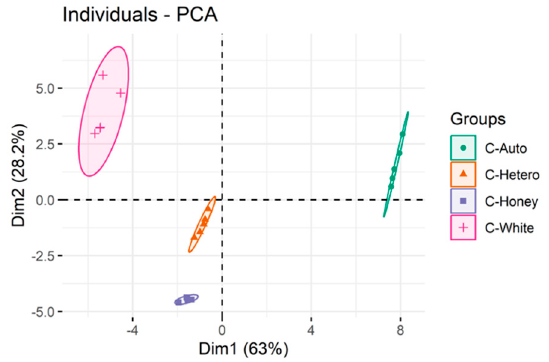
Figure 3. Principal component analysis scores plot of the 316 lipid species identified in all 4 Chlorella vulgaris strains (C − Auto, C − Hetero, C − Honey, and C − White) .